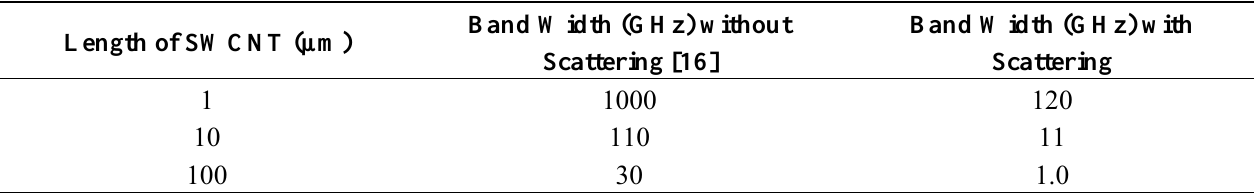
parameters of Table 1. S 12